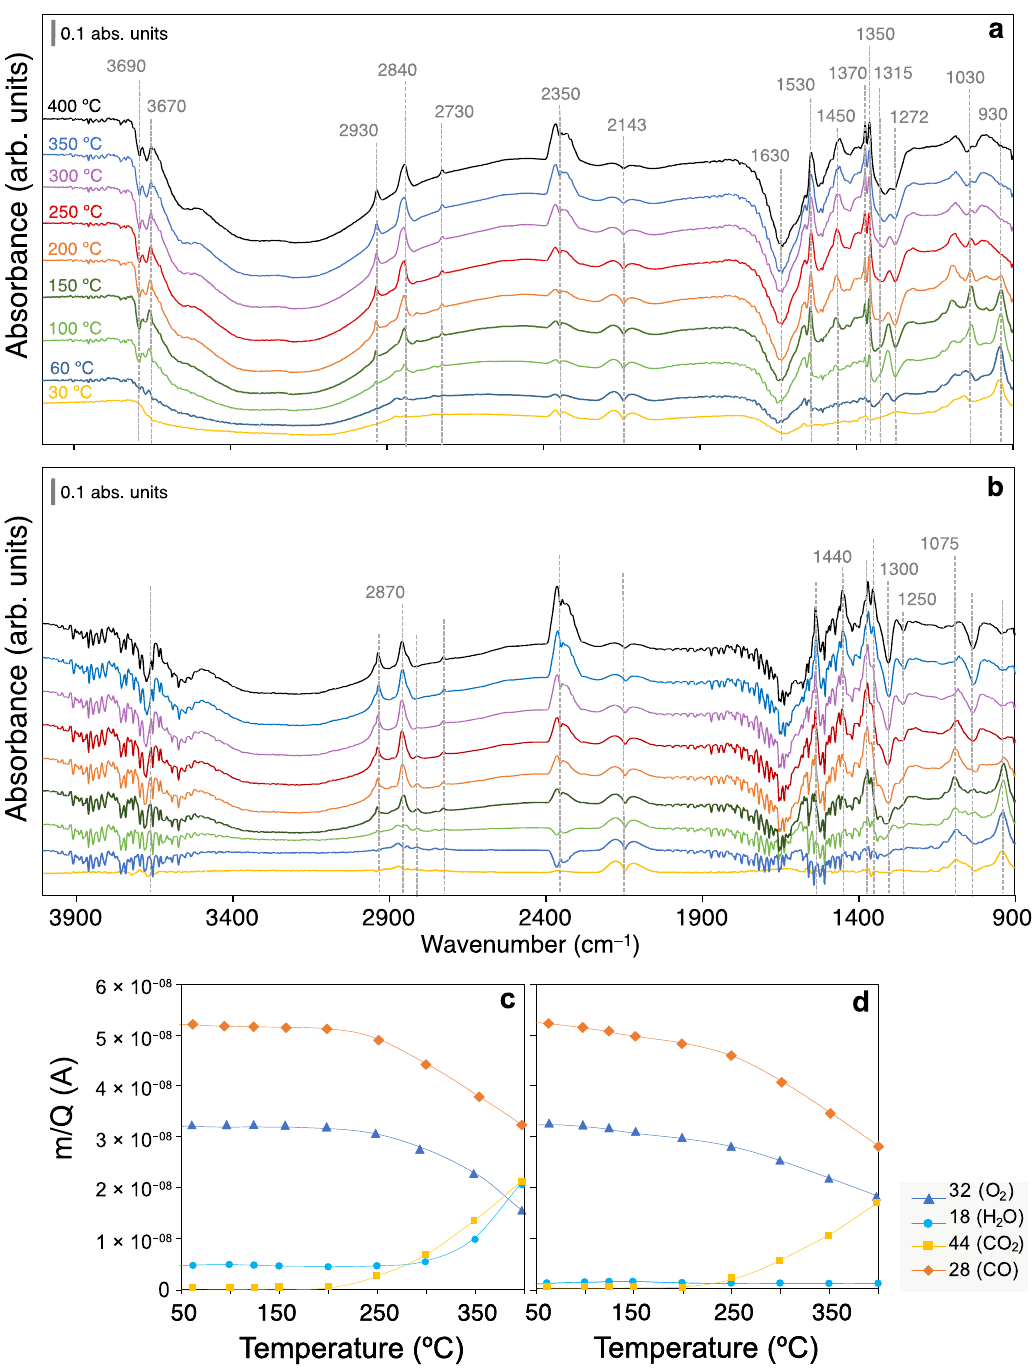
Figure 3. Operando DRIFT spectra recorded at different temperatures with the polycrystalline CeO 2 catalyst under ( a ) CO-PROX and ( b ) CO-TOX conditions. Below, evolution with temperature of the average outlet m/Q signals at steady conditions evolved from the DRIFTS reaction cell in ( c ) CO-PROX and ( d ) CO-TOX experiments.